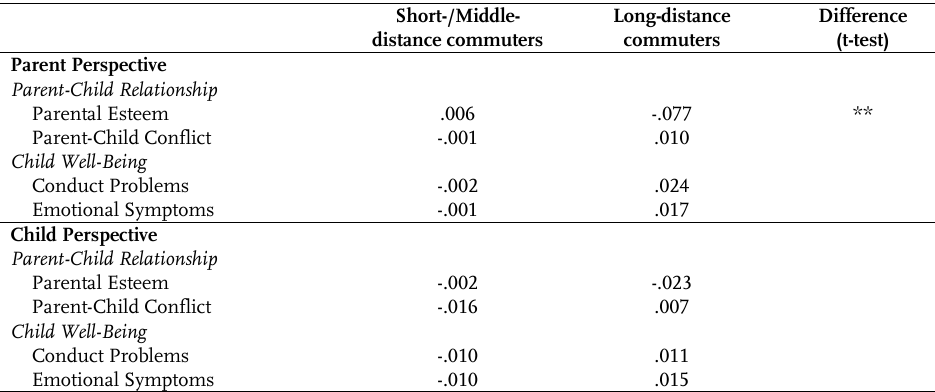
Table 3 : Comparison of mean factor scores for parent-child relationship and child well- being by commuting distance